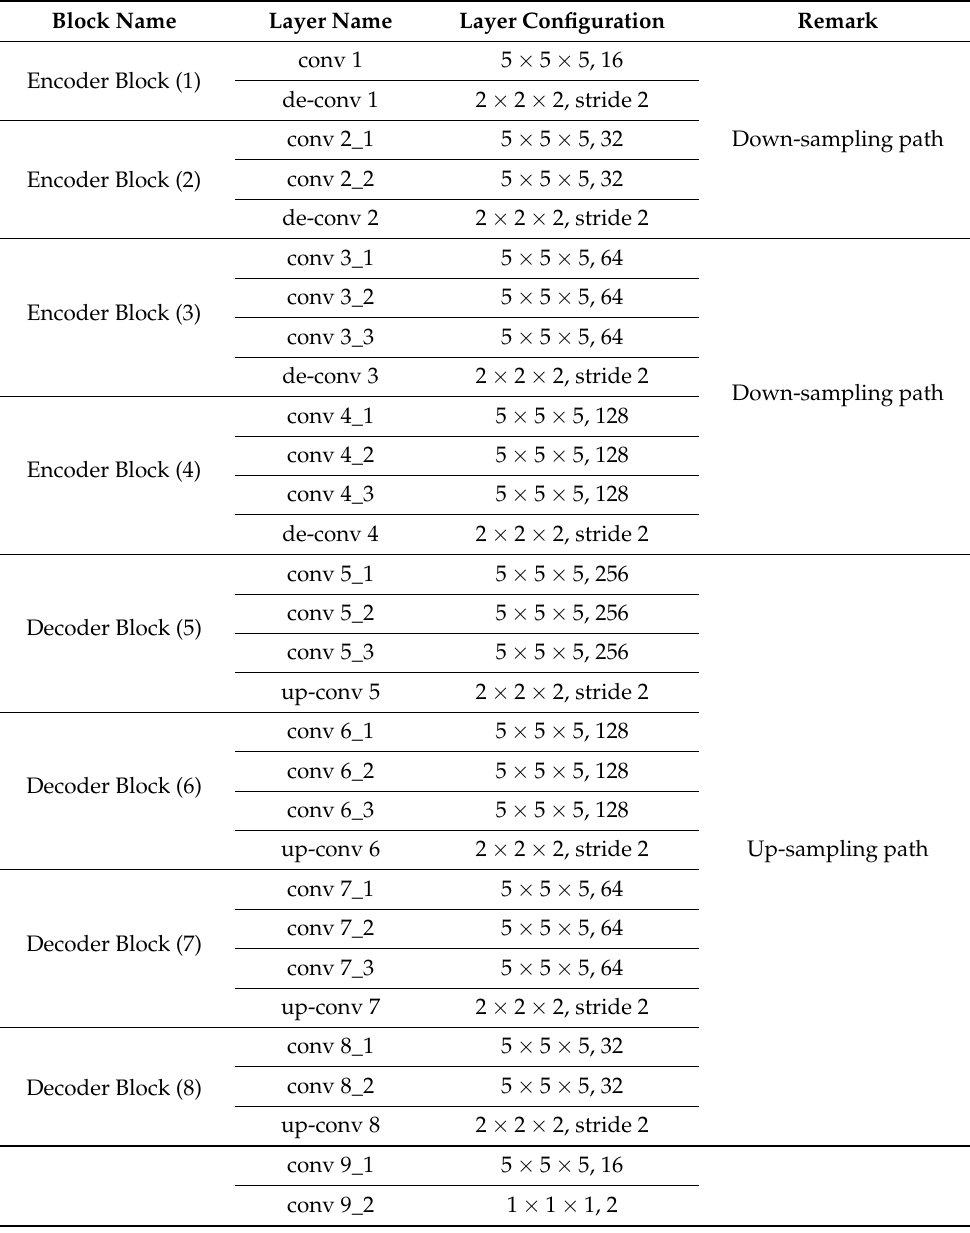
Table 1. The parameters of the convolutional neural